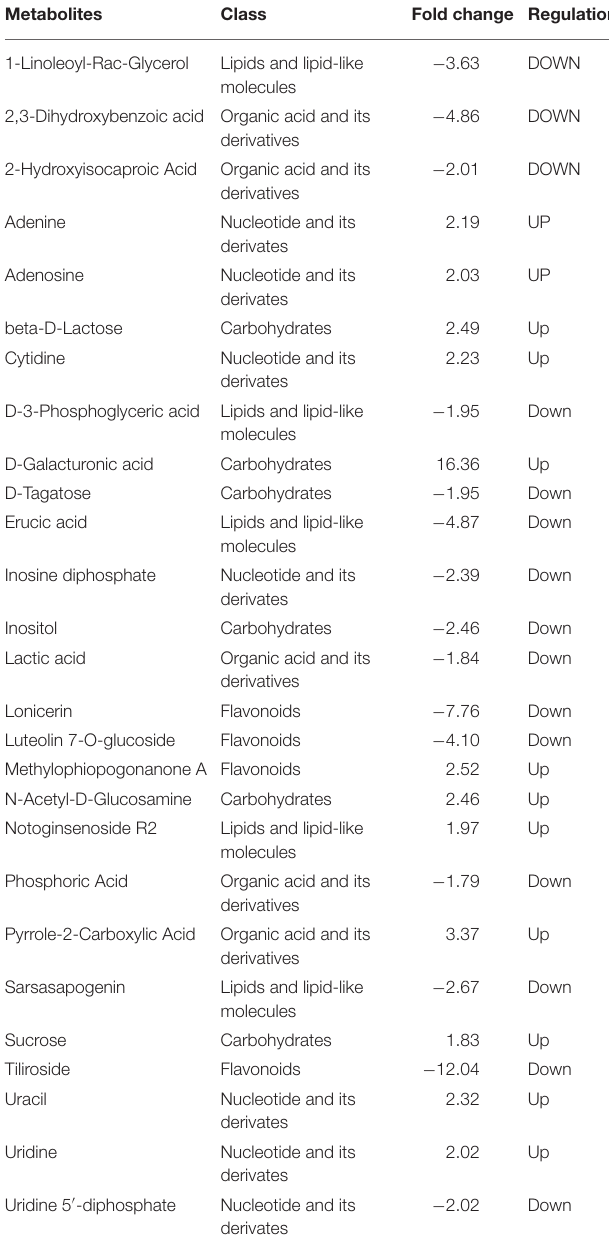
TABLE 1 | Regulation and change fold of differentially expressed metabolites involved in chilling injury (CI) process of CK 8 vs. 0 day